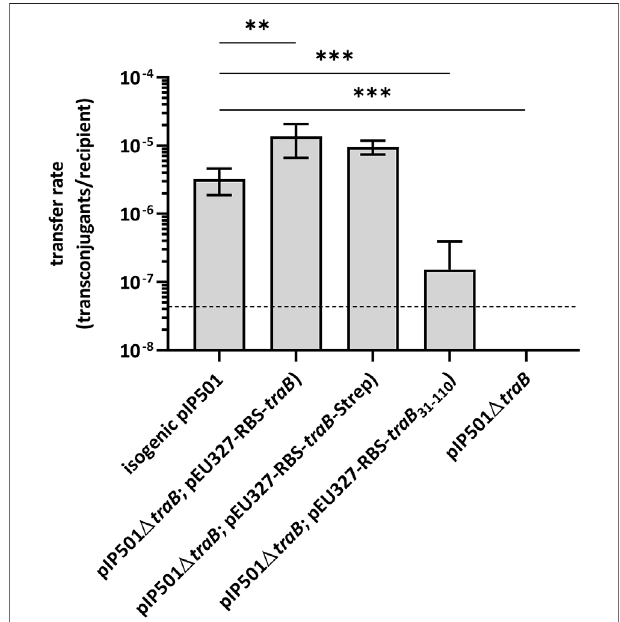
FIGURE 1 | Results of biparental mating assays of pIP501 and derivatives. E. faecalis JH2-2 isogenic wild type (pIP501), mutant strain E. faecalis JH2-2 (pIP501 Δ traB ) and complementation strain where traB, traB with a C-terminal Strep-tag or traB 31-110 are supplied in trans ( E. faecalis JH2-2 (pIP501 Δ traB ; pEU327-RBS- traB ), E. faecalis JH2-2 (pIP501 Δ traB ; pEU327-RBS- traB -Strep) or E. faecalis JH2-2 (pIP501 Δ traB ; pEU327-RBS- traB 31-110 )wereapplied asdonorsand E.faecalis OG1Xasrecipient. Transfer frequenciesarepresentedasthenumberoftransconjugantsperrecipientcell. n = 4. Mean values are depicted with the standard deviation. *** p < 0.0003, ** p < 0.0038 as determined by Welch ’ s t test. The dashed line depicts the detection limit of the assay (4.4 × 10 − 8 transconjugants per